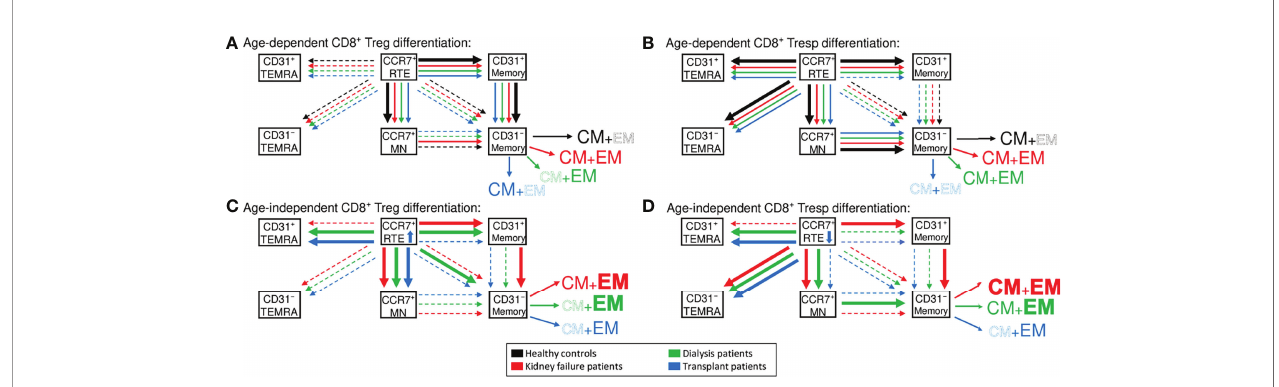
FIGURE 7 | Proposed age-dependent differentiation pathways of CD8 + Tregs (A) and Tresps (B) in healthy controls (black), KF patients (red), dialysis patients (green), and kidney transplant patients (blue). Age-independently increased differentiation pathways are shown for CD8 + Tregs in (C) and Tresps in (D) for all patient groups compared to